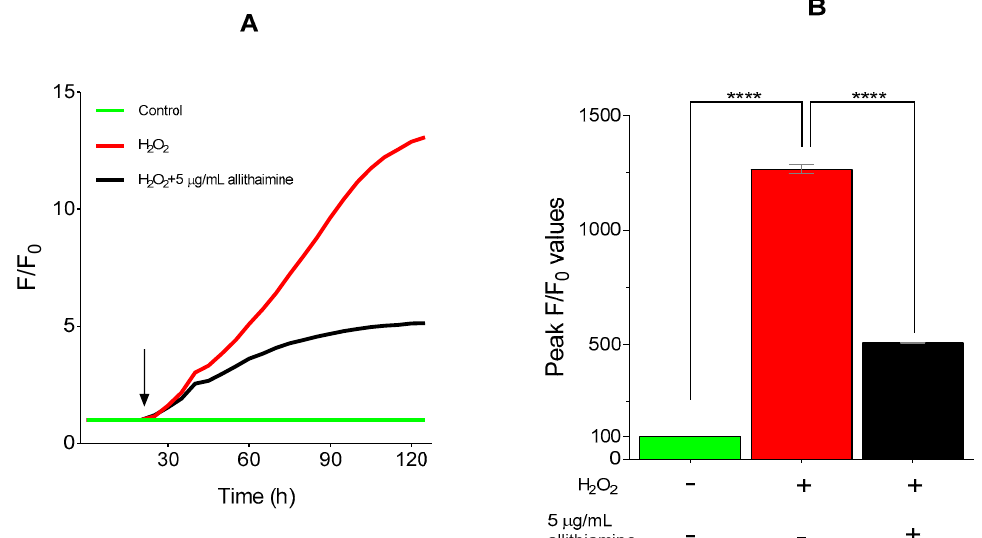
Figure 8. Antioxidative e ff ect of allithiamine in HUVECs incubated with or without 100 µ Mol / L H 2 O 2 . Fluorescent intensity was normalized to the baseline ( A ). H 2 O 2 was administrated as indicated by the arrow. Statistical analysis was performed at the peak fluorescence (F / F 0 ) values ( B ). Data are expressed as the mean ± SEM of three individual experiments. Two additional experiments yielded similar results. **** marks a significant ( p < 0.0001) di ff erence between the control and H 2 O 2 , and between H 2 O 2 and H 2 O 2 + 5 µ g / mL allithiamine. H 2 O 2 : hydrogen-peroxide. – indicates the absence of treatment substance; + indicates the presence of treatment substance.